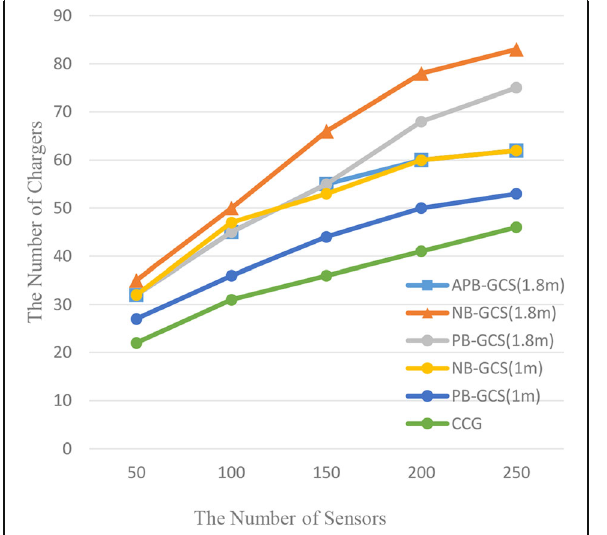
Fig. 6 Comparison between CCG, APB-GCS, NB-GCS, and PB-GCS algorithms when 100% nodes are covered once